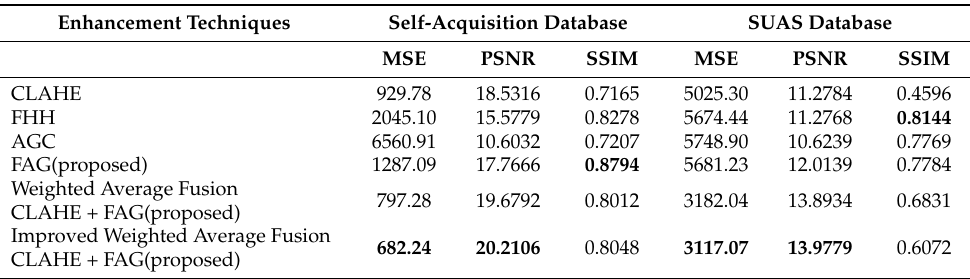
Table 1. Average results in terms of MSE, PSNR, and SSIM for various image enhancement techniques. The best values are indicated in bold.